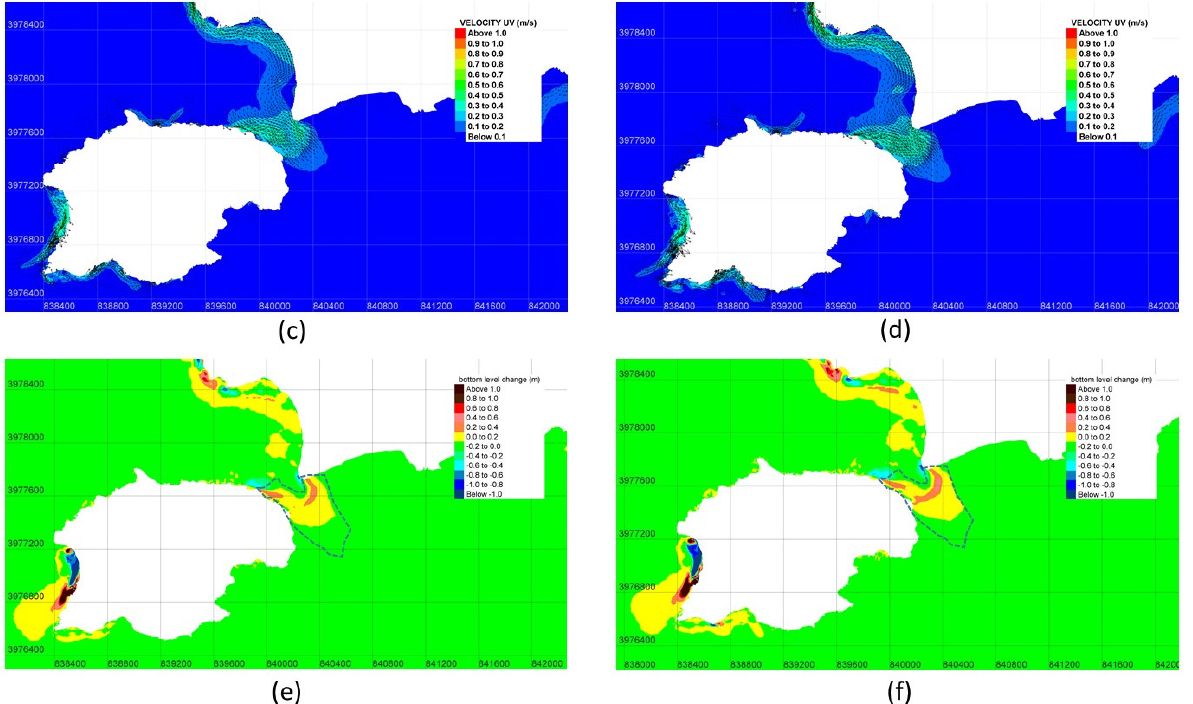
Figure 17. Maps of Hm0 (m), current velocity (m/s), and bottom level change (m) in the sea area of interest for swell wave scenario 3 ( a , c , e ) and for swell wave scenario 4 ( b , d , f ), respectively. The dotted closed line encloses the active domain of the study area for tombolo formation. Maps created in Blue Kenue™ software tool for hydraulic modellers.